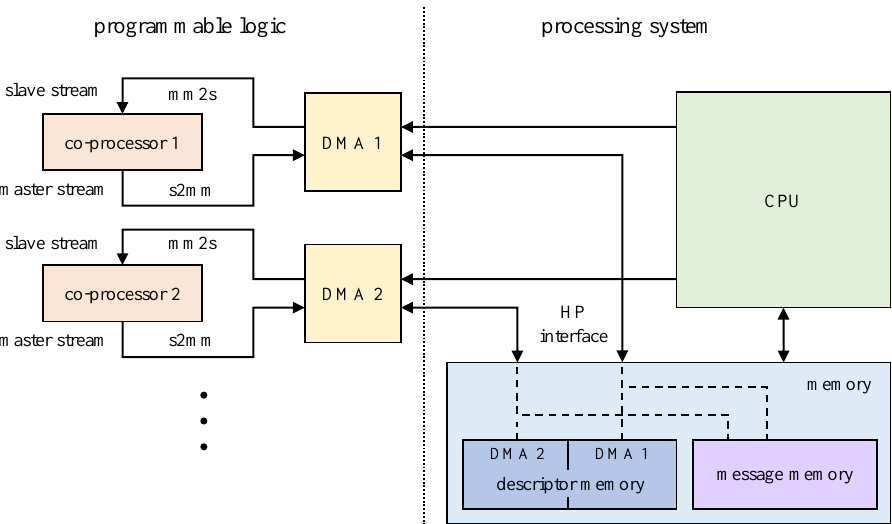
Figure 5. The block diagram depicts the connections between the programmable logic and the processing system. DMAs possess access to system memory via a high-performance interface. They stream data from the message memory to the co-processors and vise versa according to a set of descriptors. DMAs are started by the